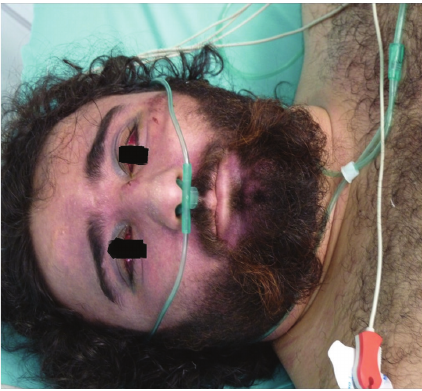
Figure 1: Bilateral subconjunctival hemorrhage.